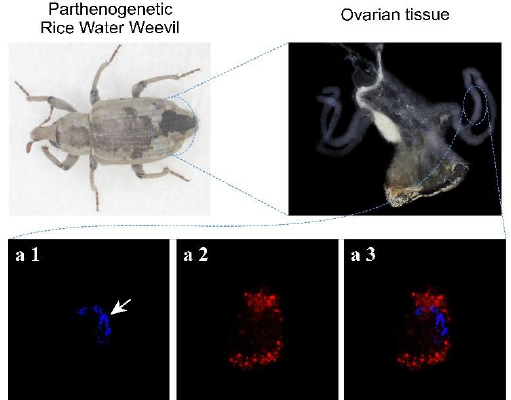
Figure 1. Observation of parthenogenetic ovarian tissue staining. Chromosomes and microtubule organization in rice water weevil (RWW) oocyte were stained with DAPI (white arrow, a1 ) and anti-Tubulin antibodies (in red, a2 ), respectively. Chromosomes move to one end of the cell during the meiosis I anaphase ( a3 ).